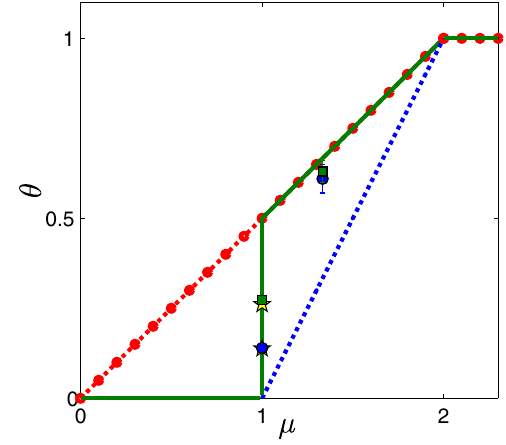
FIG. 2. Theoretical prediction of the pseudogap exponent θ vs the Lévy index of the random kicks μ . Green line: θ at the yield stress Σ c . Red-dotted line: θ after a quench, Σ ¼ 0 , overlapping with the green line for μ > 1 . Blue dashed line: Marginal values of θ , overlapping with the green line for μ > 2 , and 0 < μ < 1 . Below the blue line, the system is unstable and forbidden dynamically [16]. The data points are the measured value of θ at Σ c in the simulated mean-field model: For μ ¼ 4 = 3 , A ¼ 0 . 15 (circle), A ¼ 0 . 35 (square); μ ¼ 1 , A ¼ 0 . 15 (circle), A ¼ 0 . 35 (square), and the yellow stars are the corresponding theoretical values indicated when μ ¼ 1 .